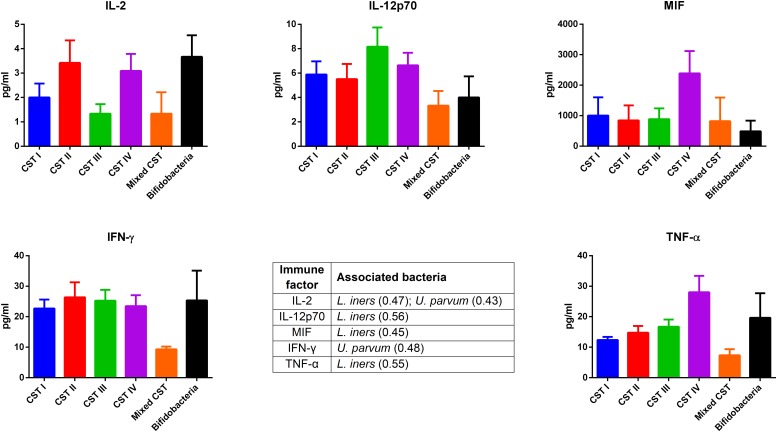
Inflammasome-independent pathway. According to the Pearson correlation score, some pro-inflammatory soluble immune factors (FDR p-value <0.001) correlated with Lactobacillus iners and Ureaplasma parvum. The association was calculated by means of the observation_metadata_correlation.py script on the rarefied otu_table.biom (5,000 reads/sample). The amount of these molecules did not vary based on the community state type (CST). The comparisons were performed by means of a Kruskal–Wallis one-way analysis of variance. When a significant p-value was observed (p < 0.05), a multiple comparison test was used to determine which groups were different. The data are shown as the mean value ±standard error of the mean (SEM). Pearson scores for every bacterial species are shown in brackets. FDR, false discovery rate.